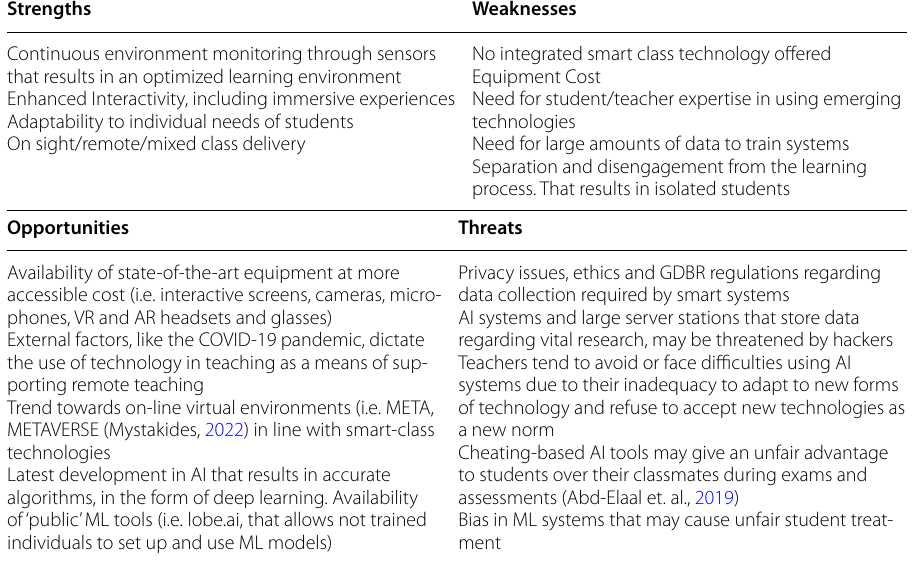
Table 7 A SWOT Analysis of AI in smart classes Strengths